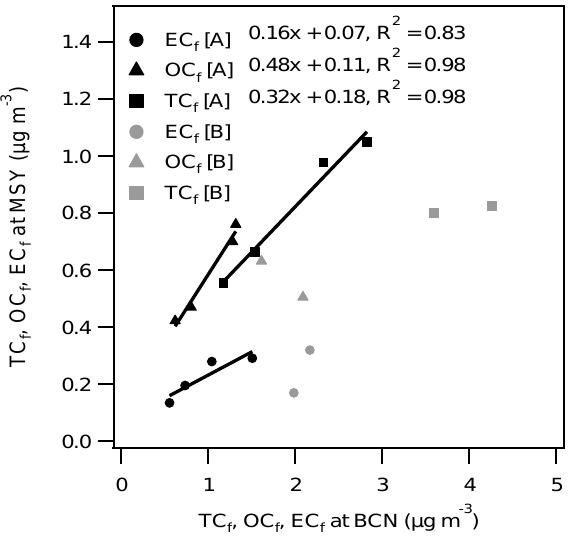
Figure 5 Fig. 5. TC f , EC f and OC f contributions at MSY vs. TC f , EC f and OC f contributions at BCN during scenario (A) and during scenario (B) . Lines and equations correspond to orthogonal distance regres-